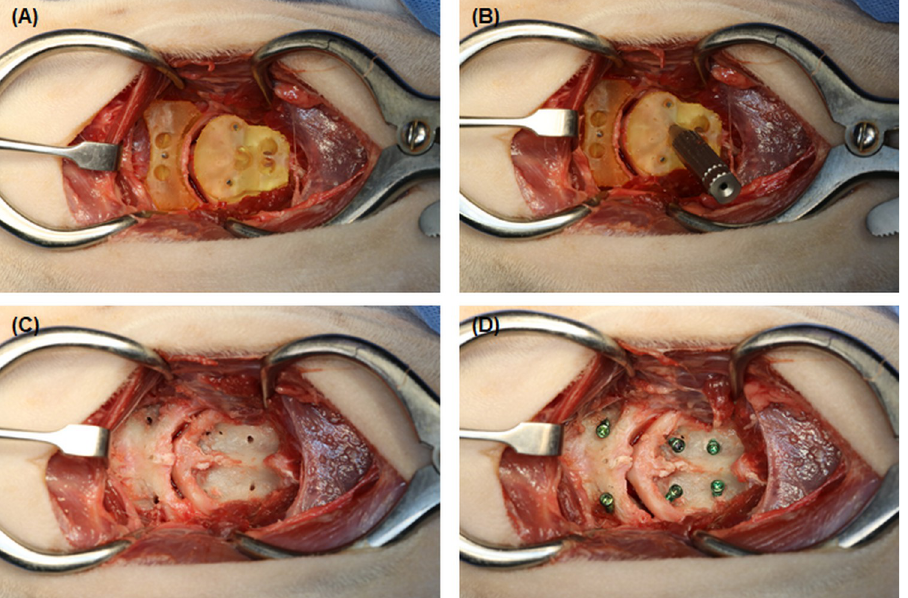
Fig 3. Application of the patient-specific guide to the cadaver. (A) Patient-specific guide of the C1 and C2 and the temporary pins inserted. (B) The drill sleeve on the patient-specific guide and the creation of a drill tract using a drilling. (C) Removal of the guide and temporary pins. (D) The surgical site with the inserted screws 3–5 mm above the